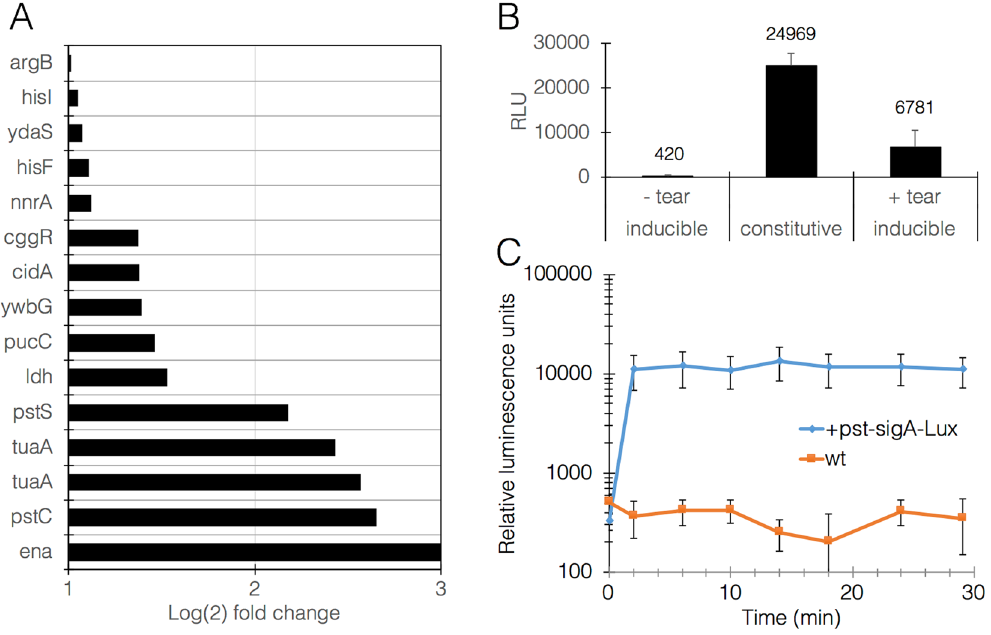
Figure 2. B. subtilis biofilm transcriptome response to mechanical tear and subsequent mounting of a reporter response. ( A ) graph representation of the most up- or down-regulated genes, in Log(2) of the fold change compared with untreated biofilm. Mean p-value for all changes is 0.007 ± 0.014. ( B ) A representative response of B. subtilis biofilms to tear, measured as relative luminescence units (RLU) derived from expression of the lux ABCDE operon under the control of pst -sigA promoter. This graph shows maximal signal achieved after 30 min. Data labels show mean values. P -value constitutive vs. + tear < 0.05; P -value -tear vs. + tear < 0.05. ( C